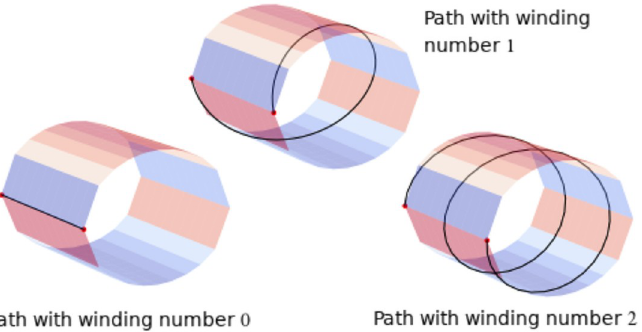
Fig 5. Three different homotopy classes of paths connecting two regions along a cylindrical surface (schematically representing an activated cluster). In general, the homotopy class of a path connecting two points on a cylinder is determined by the winding number of the path, i.e., the number of times the path winds around the central axis of the cylinder. This number is an integer: one can count clockwise winding as positive and counterclockwise as negative, or vice versa. The choice of orientation (clockwise vs. anti-clockwise) gives the two isomorphisms of the fundamental group of a cylindrical surface with the integers under addition.